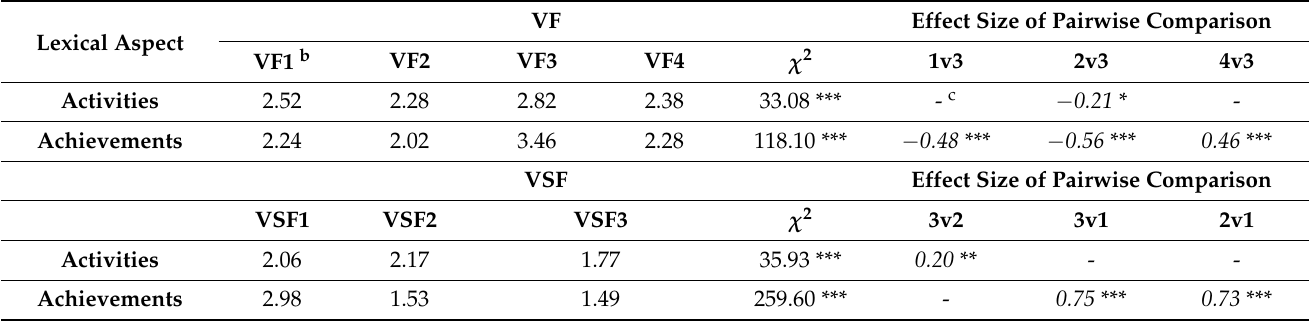
Table 4. Mean Rank of the Combinations of VF- LE /VSF- LE and Activities and Achievements a